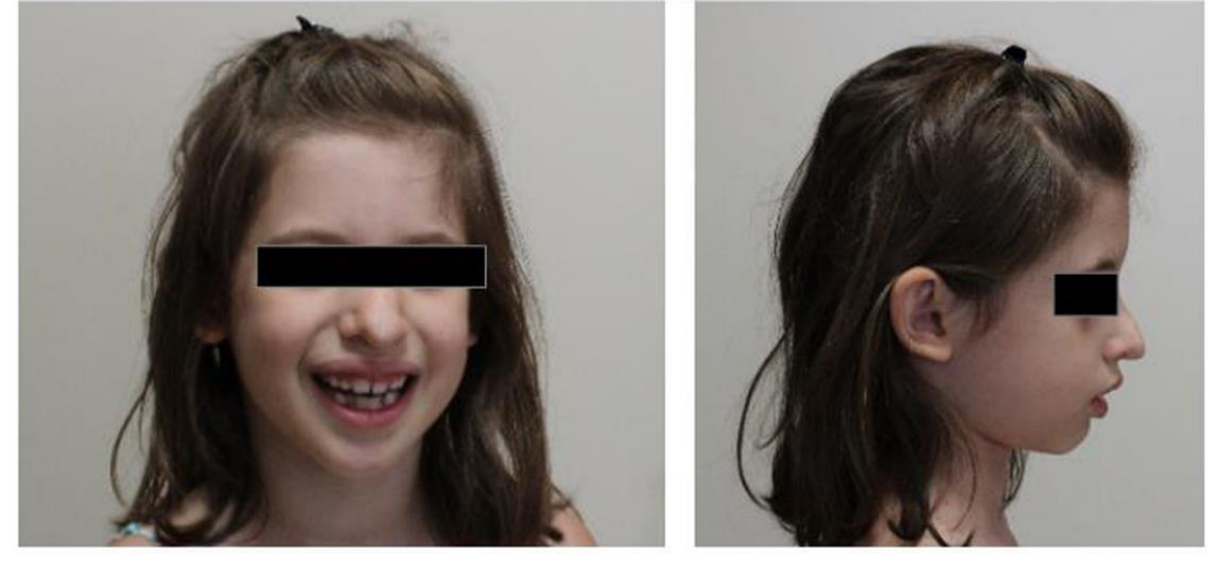
Figure 1. Facial phenotype of the patient.